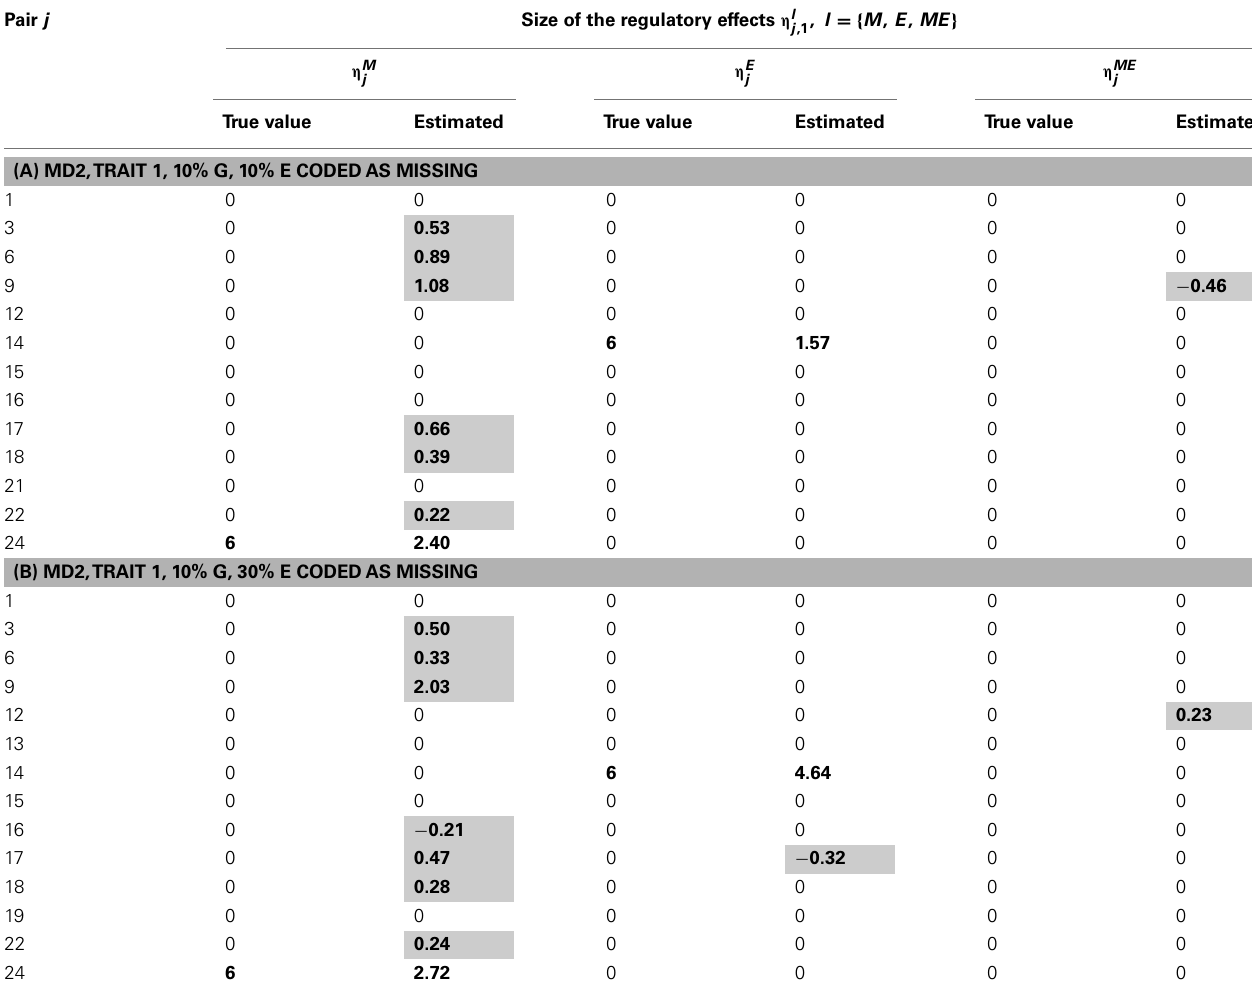
Table 9 |True and estimated (posterior means) cQTL effects in the analysis ofTrait 1 using the MD2 version of the HB single-trait cQTL model with (A) 10% markers and 10% expressions coded as missing and (B) 10% markers and 30% missing expressions coded as missing, and for Bernoulli parameter s l =